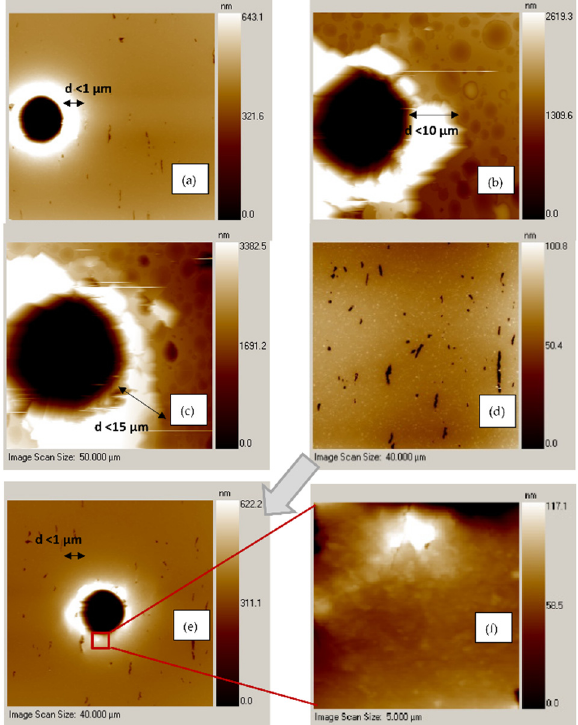
Figure 4. SPI images from indentation testing (spherical cone indenter of 5µm of diameter) for ( a ) BB05, ( b , c ) BB07 and ( d – f ) the enlargement of the microstructural damage due to indentation in a BB05 sample. ( d , e ) shows an area of a BB05 sample before and after the indentation, while ( f ) is an enlargement of the damaged area squared in red in ( e ).